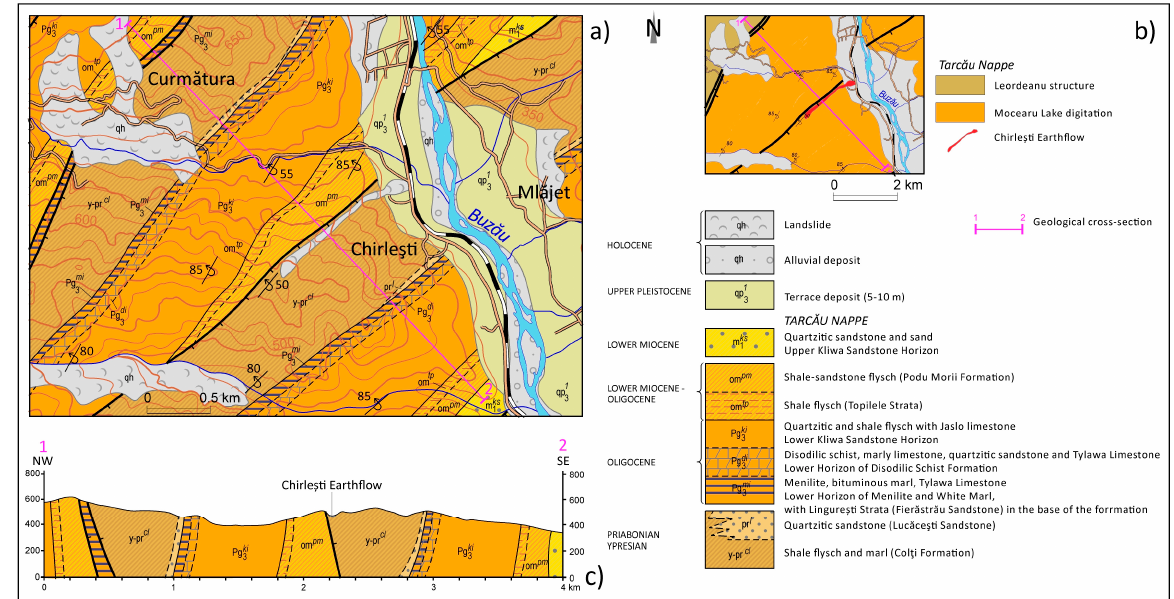
Figure 2. Geology of the study area: geologic map ( a ); tectonic sketch ( b ); geological cross-section ( c ). Data from [32].